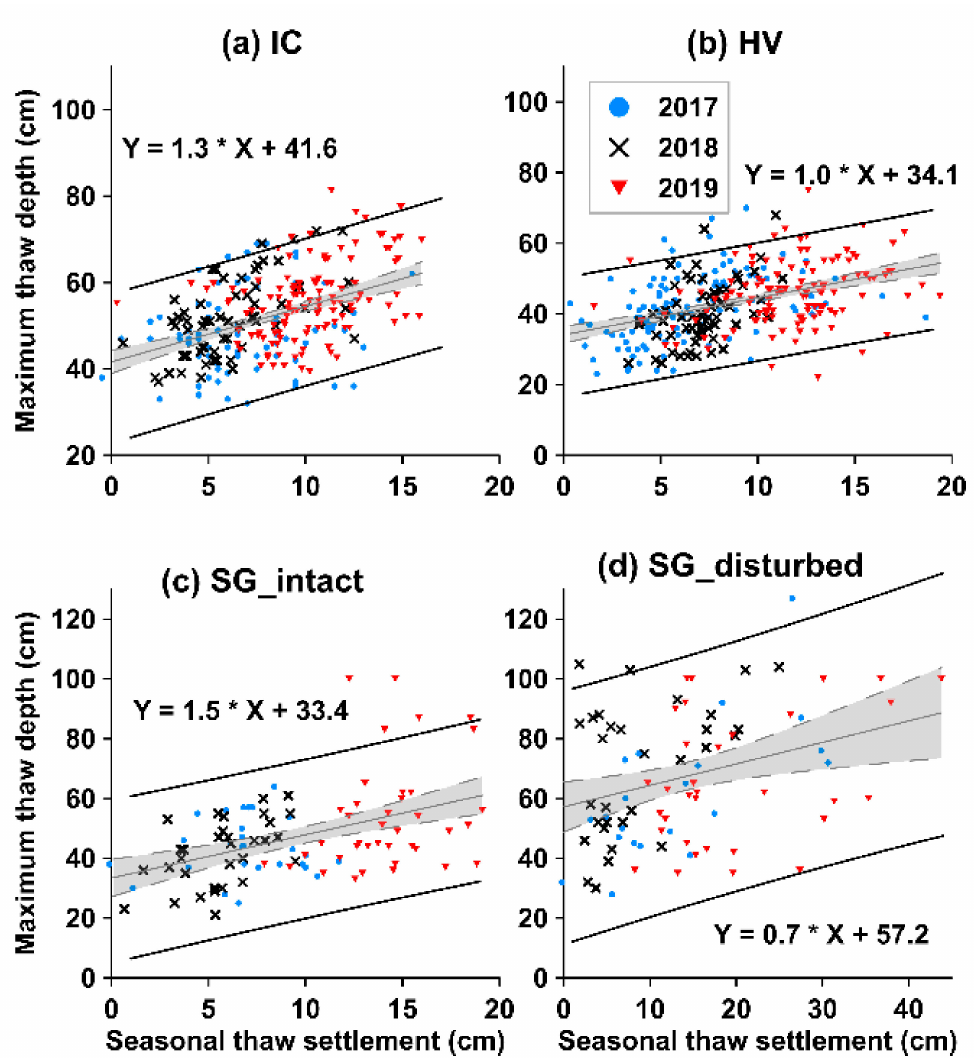
Figure 8. Scatter plots of the maximum thaw depth against the seasonal thaw settlement for IC, HV, SG_intact, and SG_disturbed points. A linear regression curve with its 95% confidence interval is shown in gray for each plot. The 95% prediction intervals are also shown in solid black lines for each plot. The equation for each plot is a linear regression